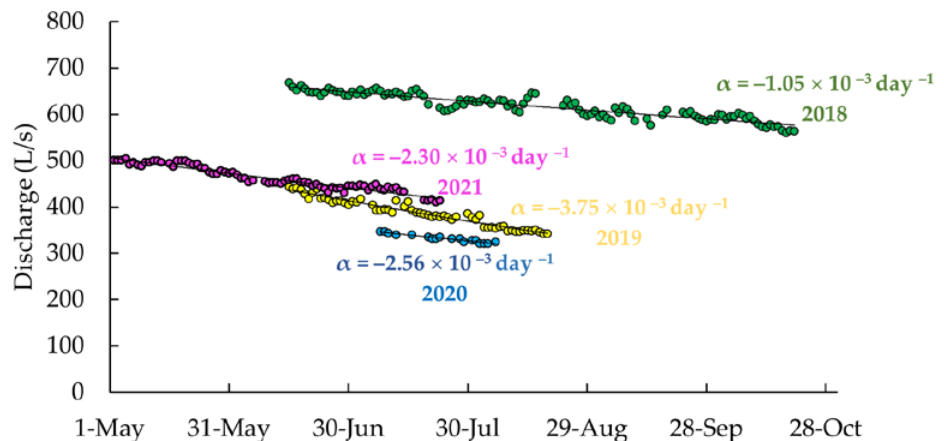
Figure 5. Recession periods of St1 for the years 2018, 2019, 2020, 2021, with Maillet depletion coefficients. The black solid lines represent the exponential fitting of daily discharge data with R2 values ranging between 0.85 and 0.94 (not shown).